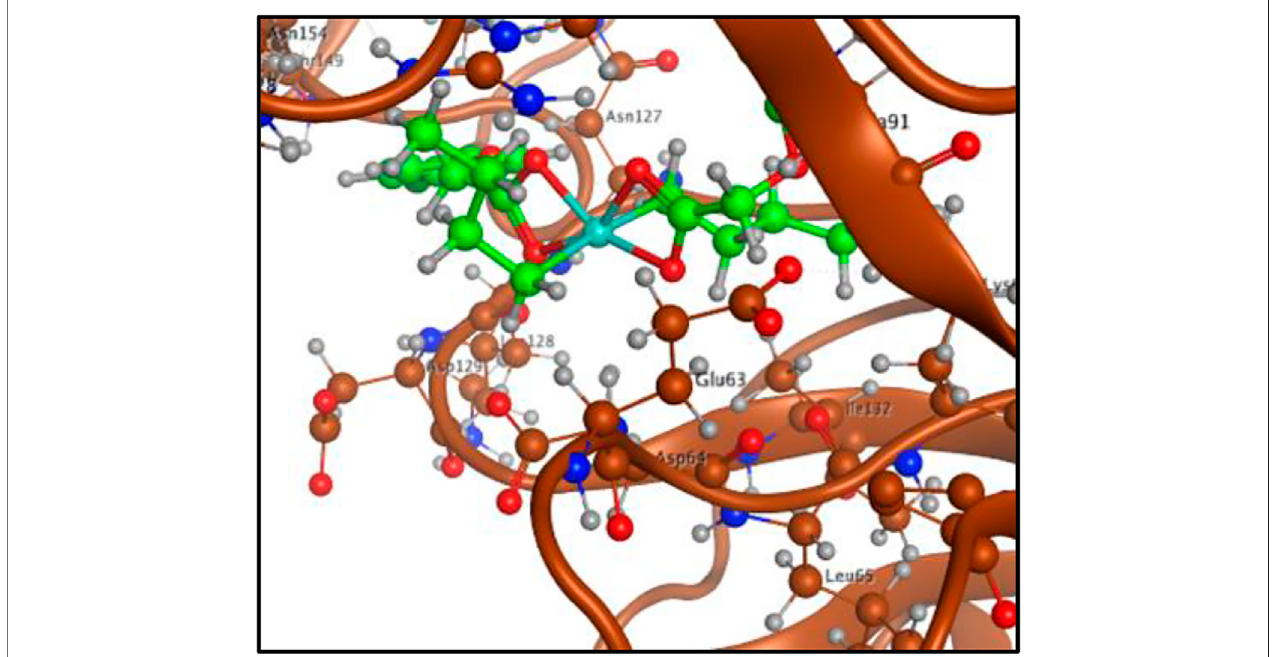
FIGURE 9 | Complex 1 -nucleocapsid protein interaction.